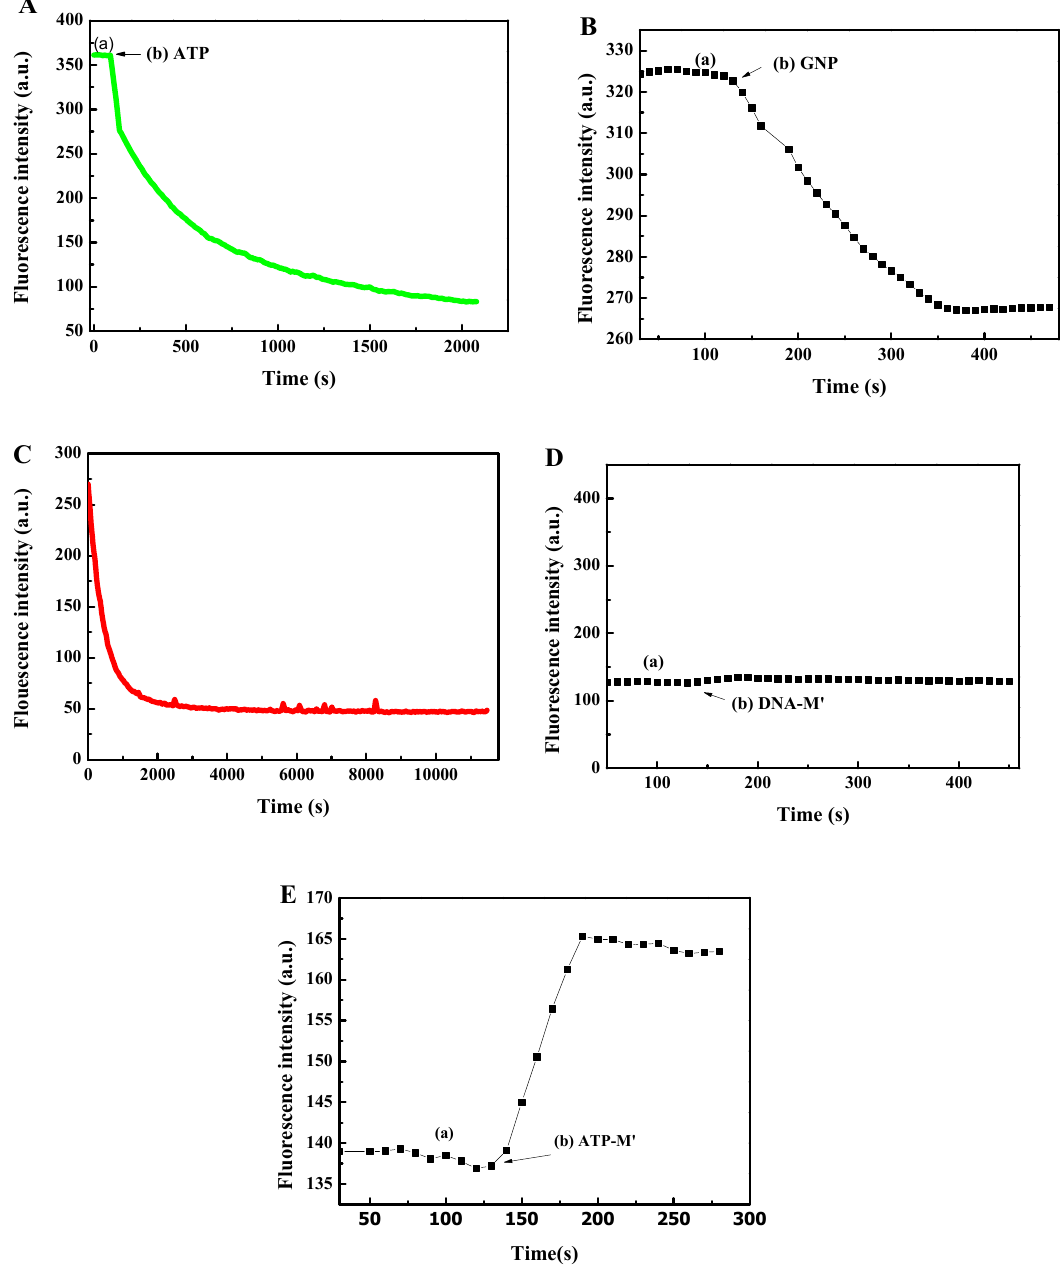
Figure 2. Monitoring of the reaction progress under various conditions: ( A ) (a) DNA-T+DNA-M dsDNA; (b) 200 µL of 10 µM ATP. ( B ) (a) DNA-T+DNA-M dsDNA; (b) GNP. ( C ) DNA-T+DNA-M dsDNA, GNP, and 200 µL of 10 µM ATP. ( D ) (a) DNA-T+DNA-M dsDNA and GNP; (b) DNA-M ′ . ( E ) (a) DNA-T+DNA-M dsDNA, GNP, and 200 µL of 10 µM ATP; (b) DNA-M ′ .